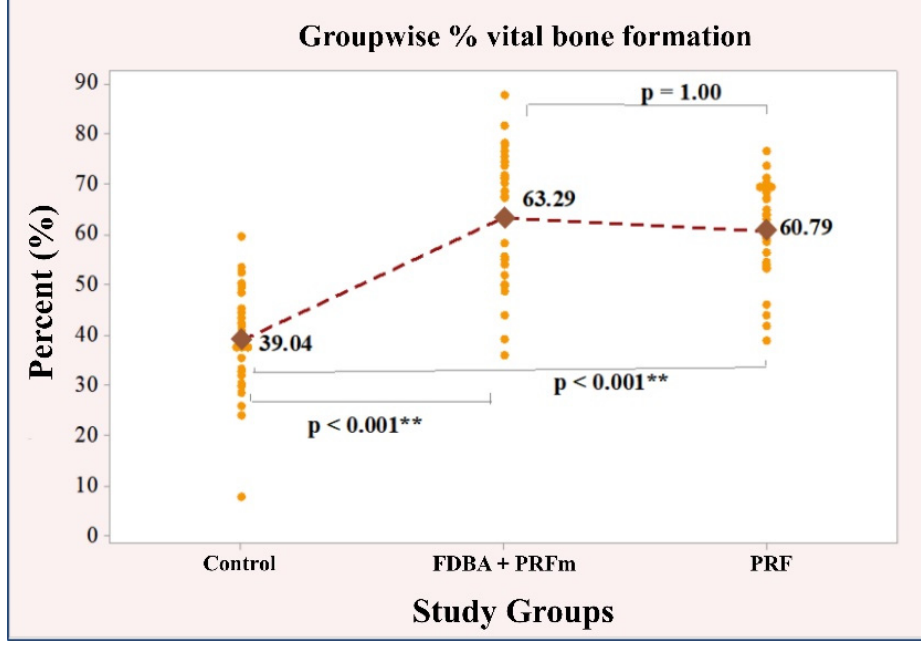
Figure 8 . Individual and mean arithmetic values of % vital bone. ** denotes significant difference between groups.